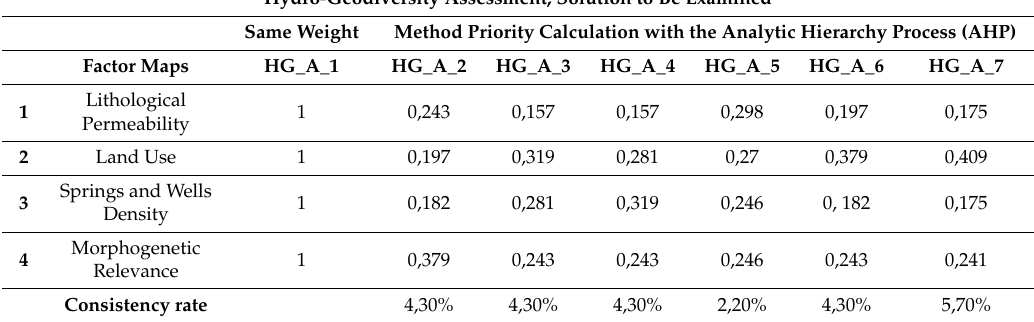
Table 5. Hydro-geodiversity assessment solutions. The underline values indicate the group of factors that has more weight in the map algebra process. Hydro-Geodiversity Assessment; Solution to Be